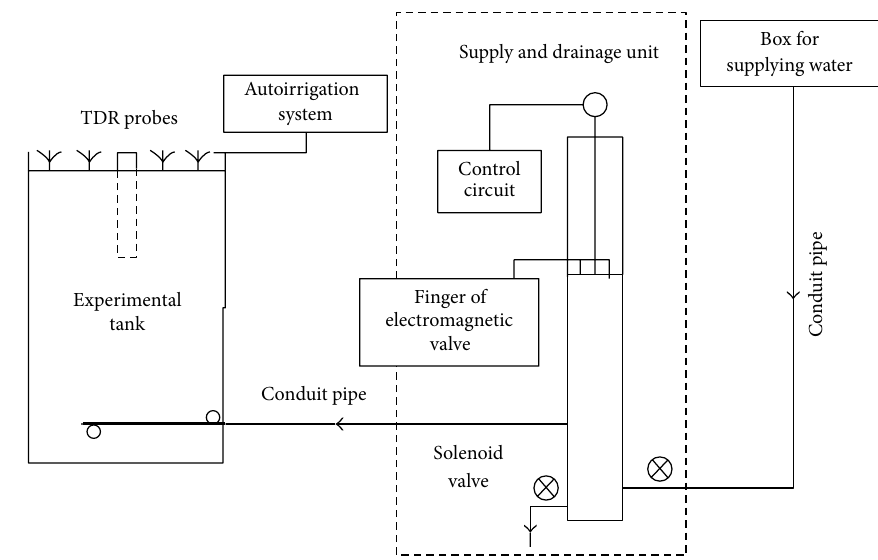
Figure 1: Schematic diagram of the experimental setup placed in the